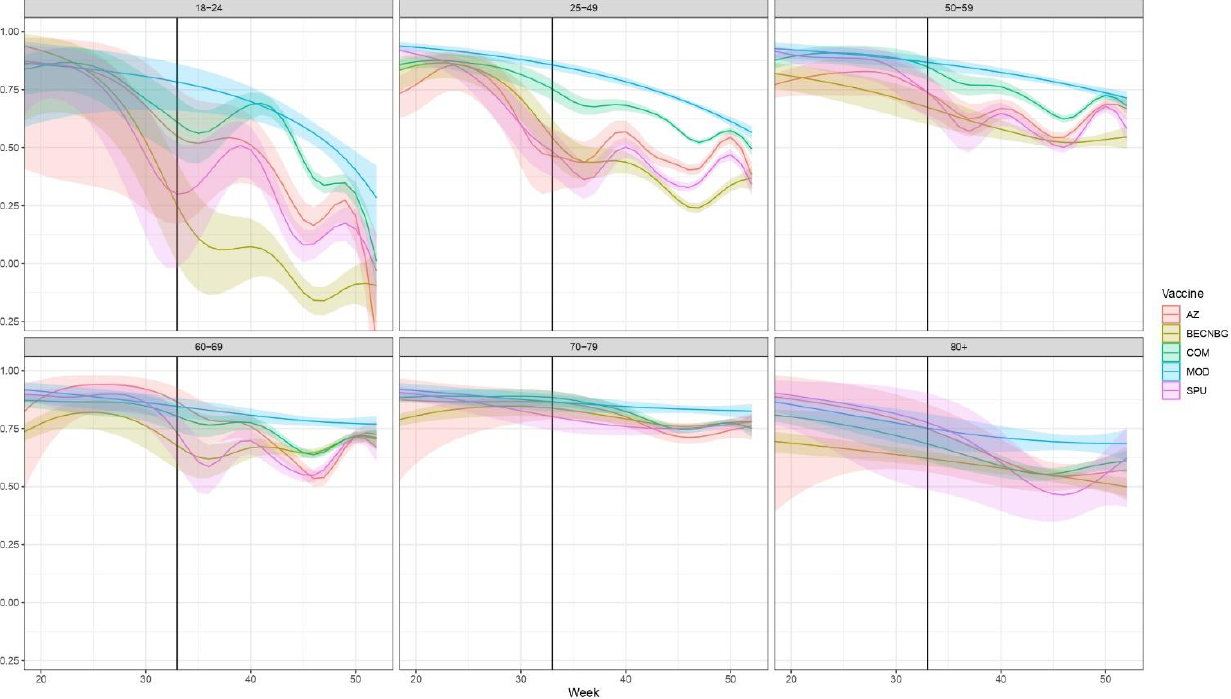
Figure 2. Evolution of VE against laboratory-confirmed COVID-19 over time, stratified according to age, week and vaccine brand of the primary series in Hungary from week 20 to week 52, 2021. (Due to the low number of people infected who were vaccinated with the Janssen vaccine or were below 18, the VEs for these are not presented in Figure, but are given numerically in Supplementary Tables S2–S4.) Abbreviations are the same as in Figure 1. Shaded areas indicate 95% confidence intervals. The start of the effect of booster doses from week 33 is shown by a vertical black line; after that, the results pertain not only to the primary vaccine indicated but to an—unknown— combination of the primary vaccine and the booster. Booster doses were almost exclusively mRNA vaccines (Figure